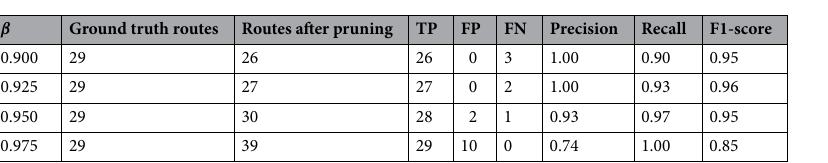
Table 1. Results for the triangle inequality pruned graph in Styria, Austria with 15 locations.